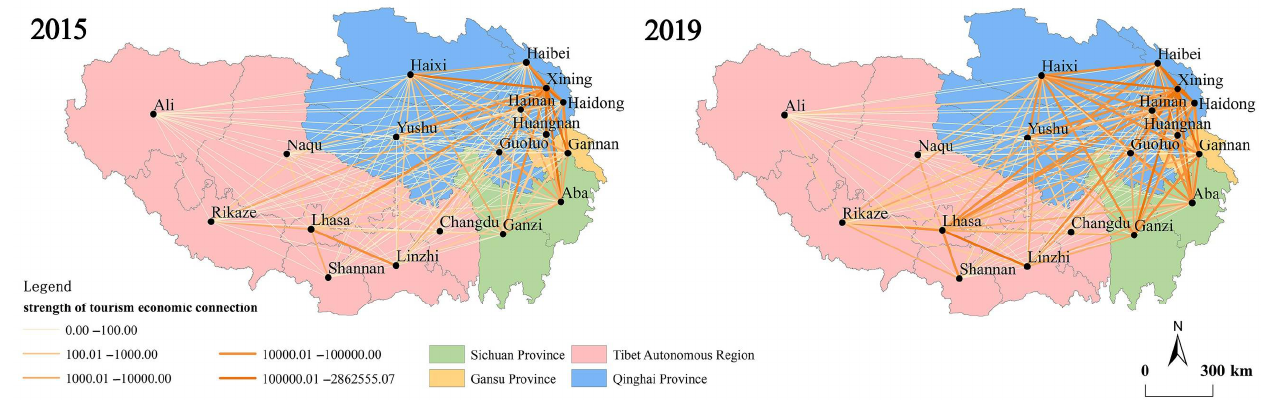
Figure 2. Strength of the tourism economic connection.